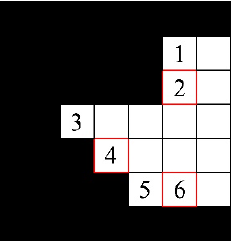
Figure 8. Example of the smooth pixel point determination. The numbers 1–6 denote the candidate deletion points extracted by the ZS thinning algorithm, where 2, 4, and 6 denote the smooth pixel points.